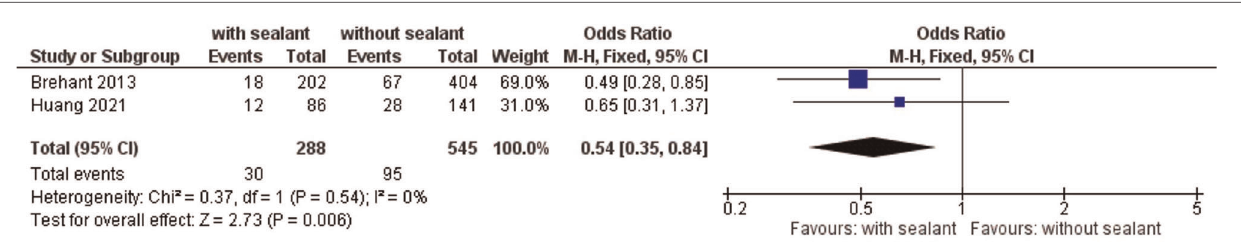
FIGURE 4 | Fixed-effects meta-analysis for the postoperative major complication rate according to the Clavien – Dindo classi fi cation of surgical complications (43) in the intervention (coated or reinforced anastomoses) and control group. The forest plot of all studies is